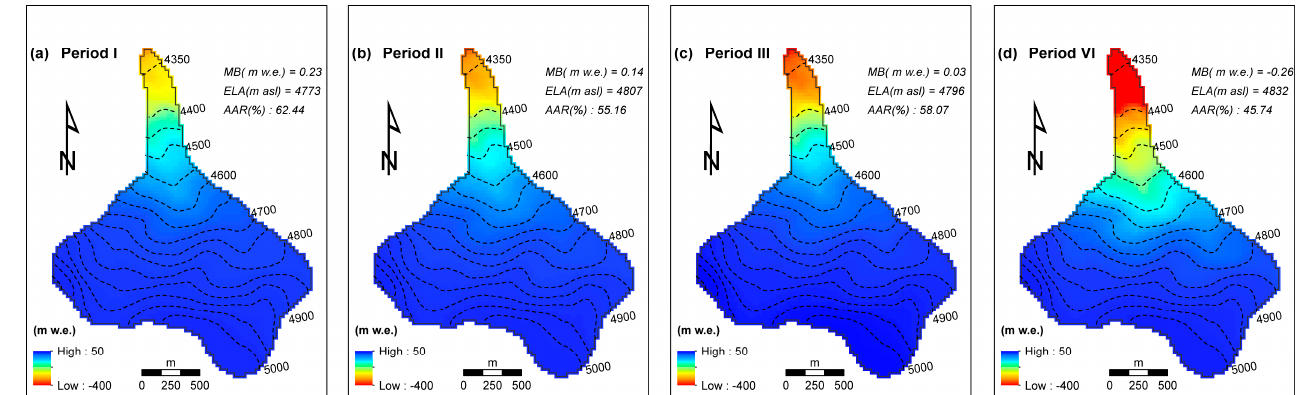
Figure 8. The spatial mean annual mass balance (MB) variation during Period I (1957–1969, a ), Period II (1970–1979, b ), Period III (1980–1991, c ), and Period VI (1992–2013, d ).